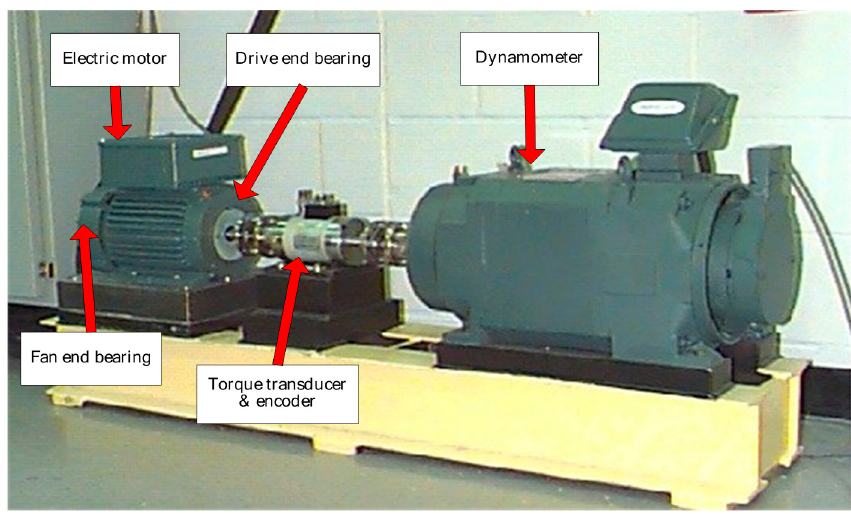
Figure 11. The bearing test rig of the CWRU Bearing Data Center [29]. Table 1. Bearing details and fault frequencies.